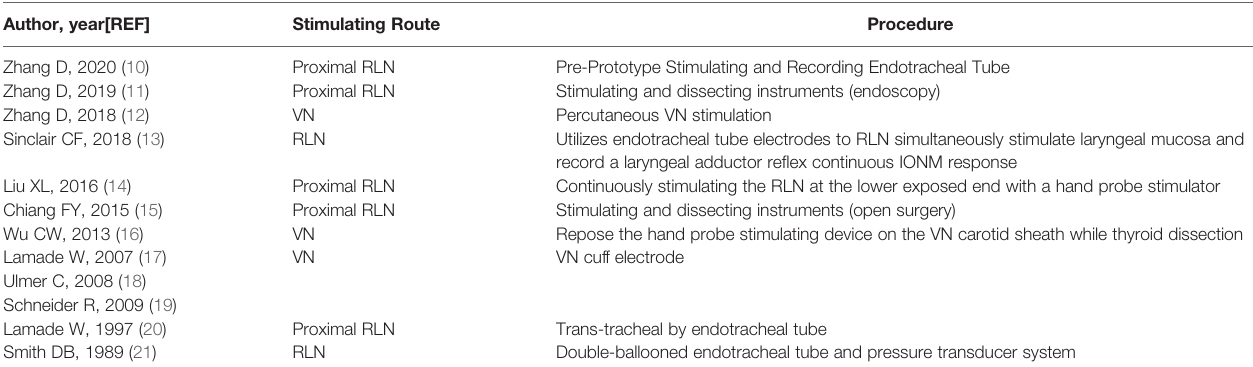
TABLE 1 | New modalities for